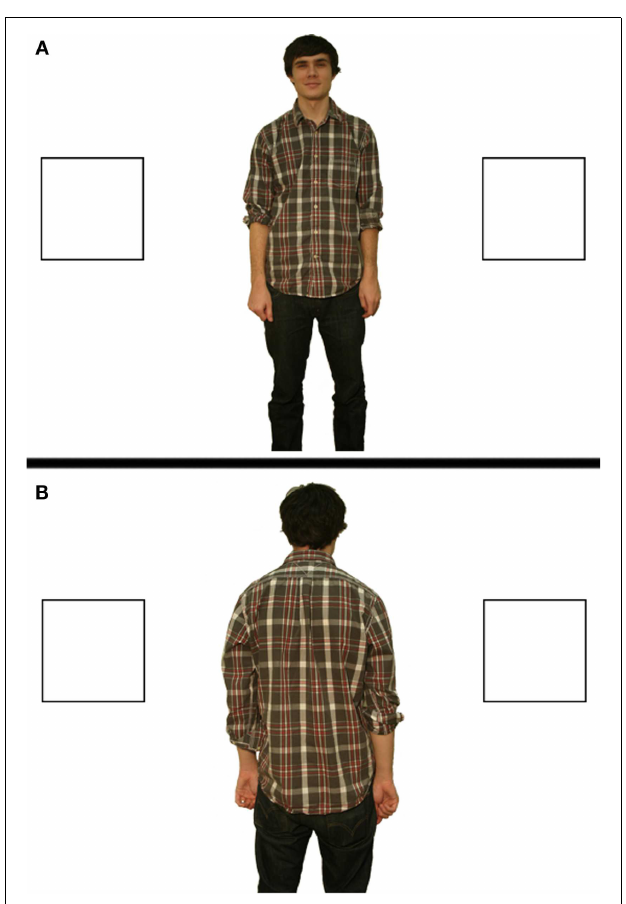
FIGURE 3 | Stimuli used in Experiment 1b for the Opposite Perspective condition [(A), top] and the Shared Perspective condition [(B), bottom] .